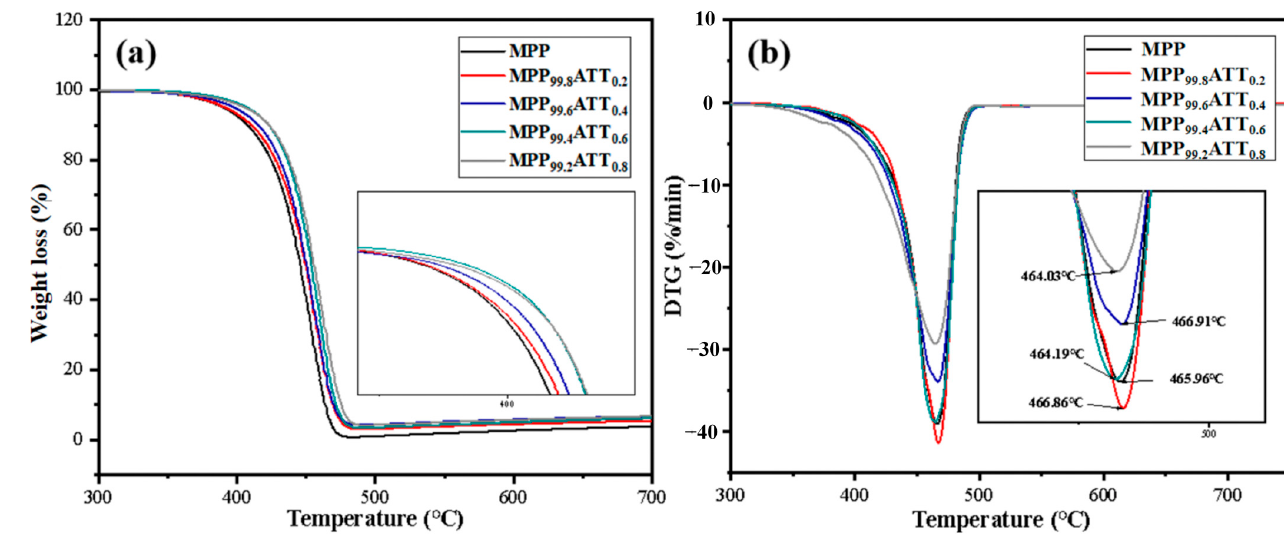
Figure 8. Differential and thermal gravimetric analysis for MPP and MPP/ATT nanocomposites: ( a ) weight loss (%) vs. temperature; ( b ) derivative mass (DTG) vs. temperature. Table 4. Thermogravimetric/differential analysis of MPP/ATT nanocomposites.